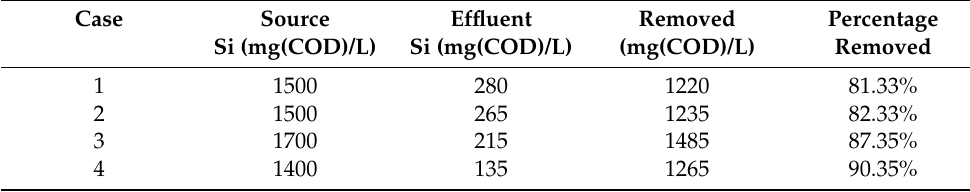
Table 5. Values of propionate concentrations and the rate per 100